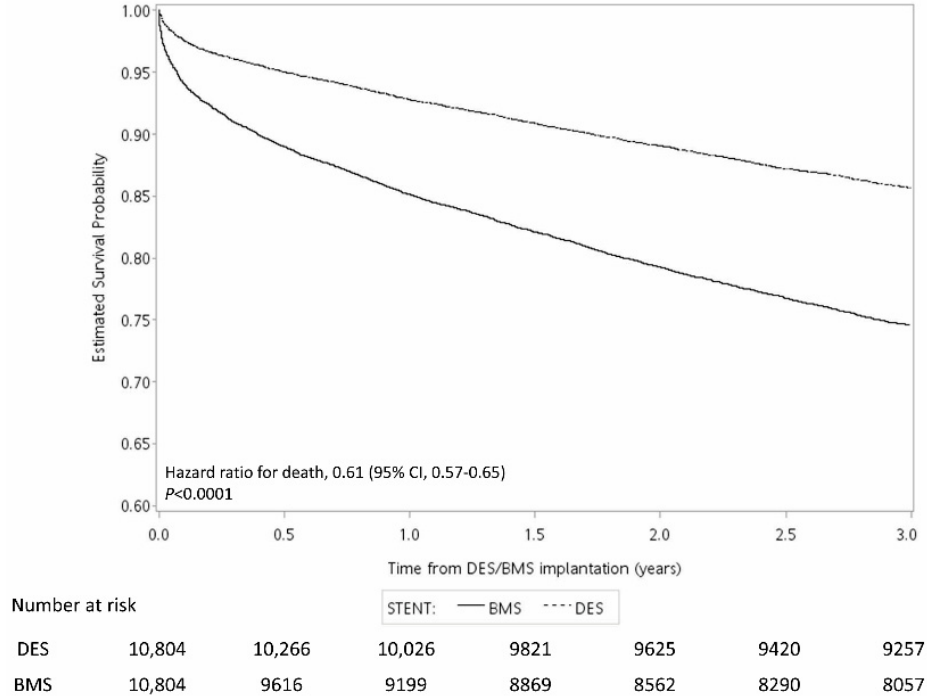
Figure 4. Kaplan–Meier curve for the risk of mortality within three years after surgery.